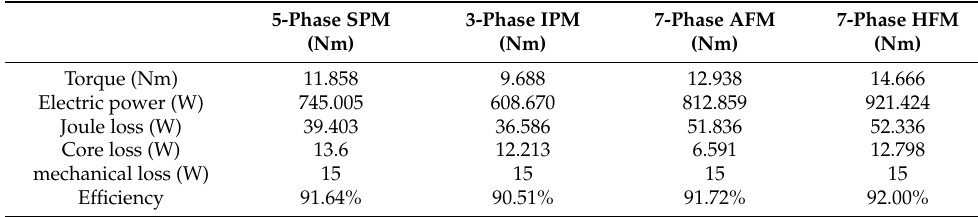
Table 5. Efficiency of four machines.